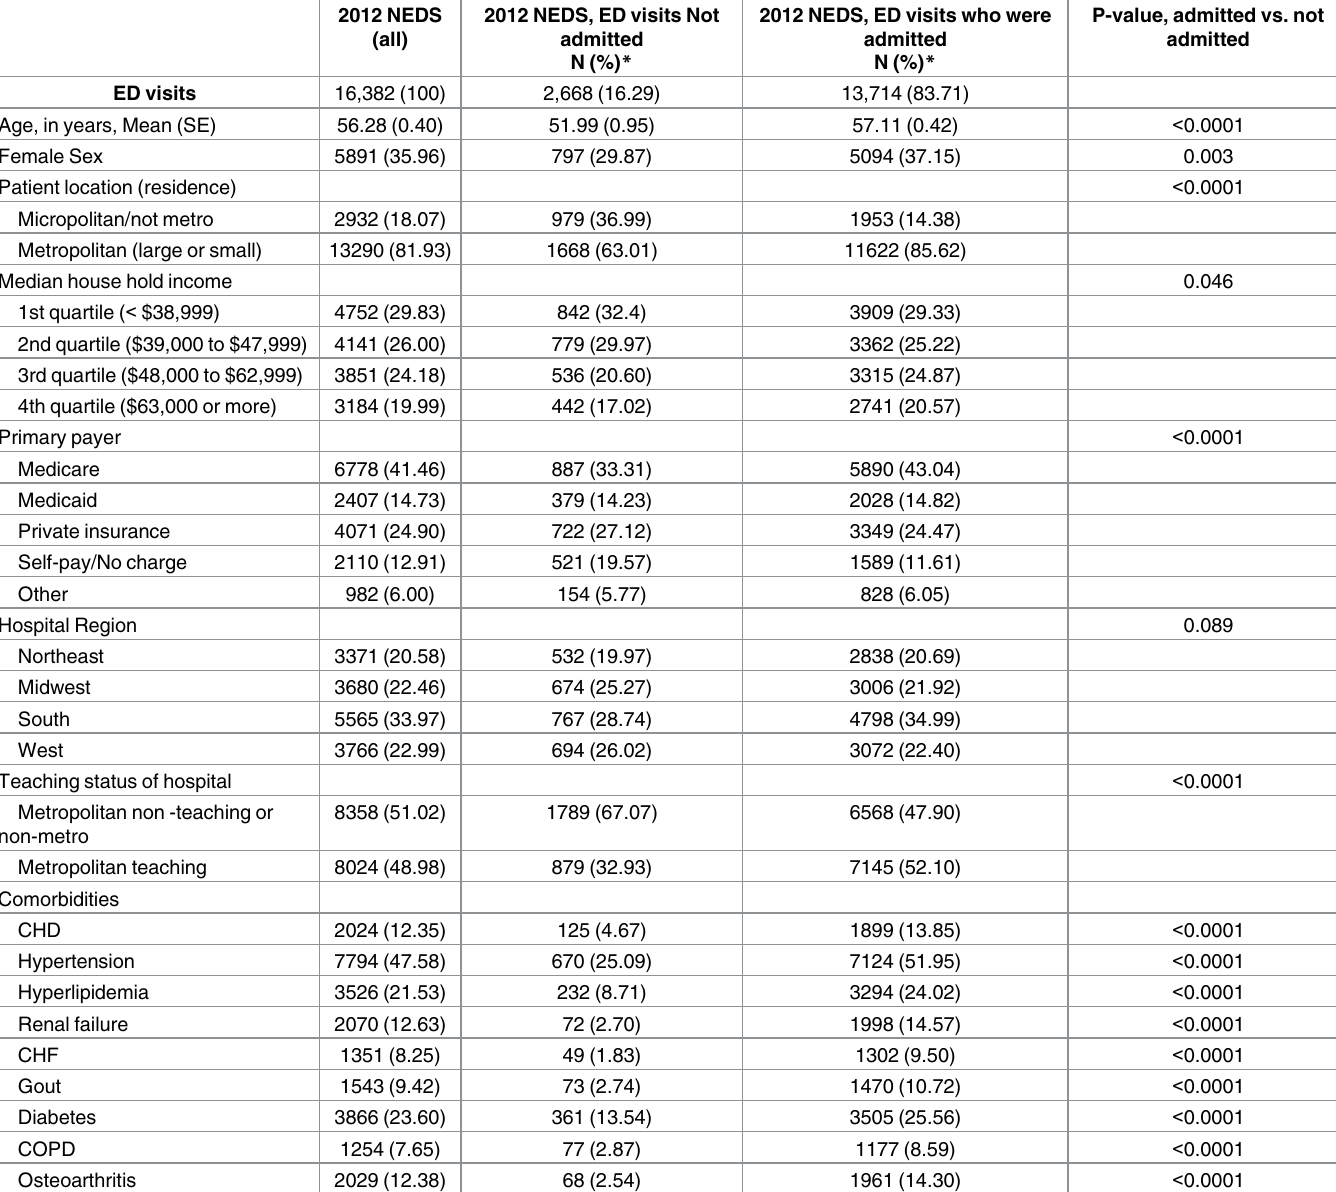
Table 2. Characteristics of patients with septic arthritis ED visits who were hospitalized compared to those not hospitalized. 2012 NEDS 2012 NEDS, ED visits Not (all)